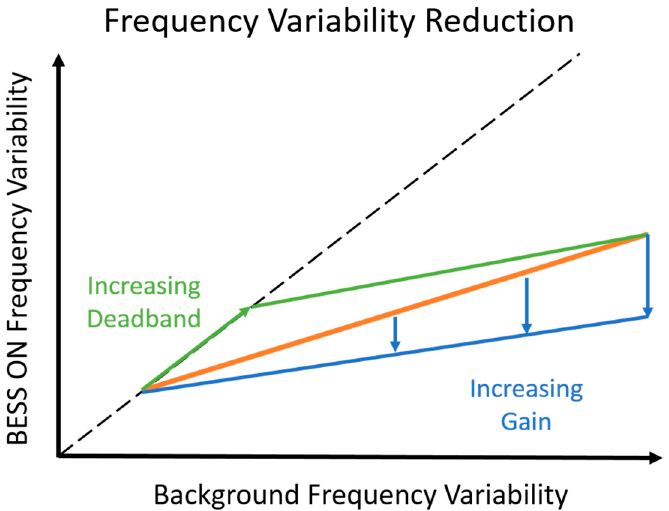
Figure 8. A diagram of the effects of increasing deadband and increasing gain on the ability of the BESS to reduce grid frequency variability (top plots of Figures 6 and 7). The orange line represents a reference parameter set, the green line represents the effect of increasing the deadband only, and the blue line represents the effect of increasing the gain only. The deadband determines the minimum frequency values to which the BESS responds; for frequency values below the deadband the BESS has no effect (green). At high frequency variability, a larger proportion of frequency values lie outside the deadband, so its influence is weaker, and the BESS effectiveness is determined by the gain setting (blue).